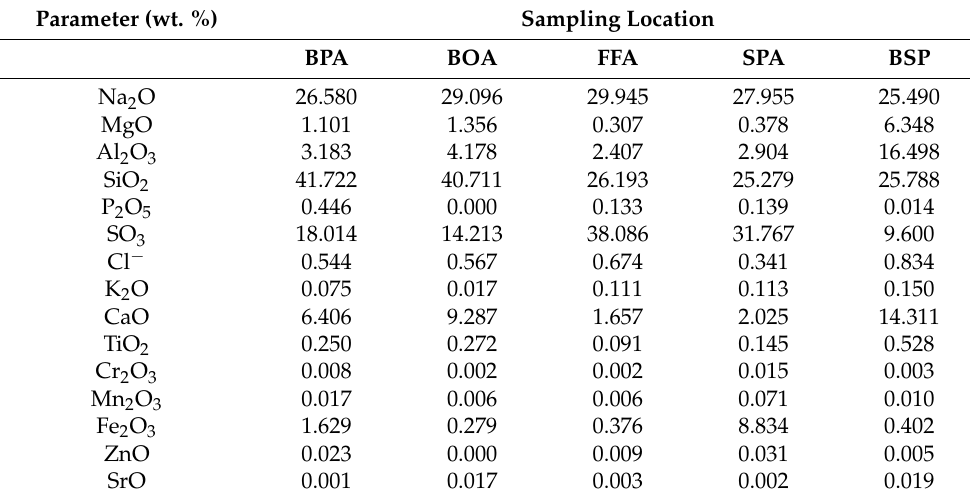
Table 5. Characterization of Particulate Matter.